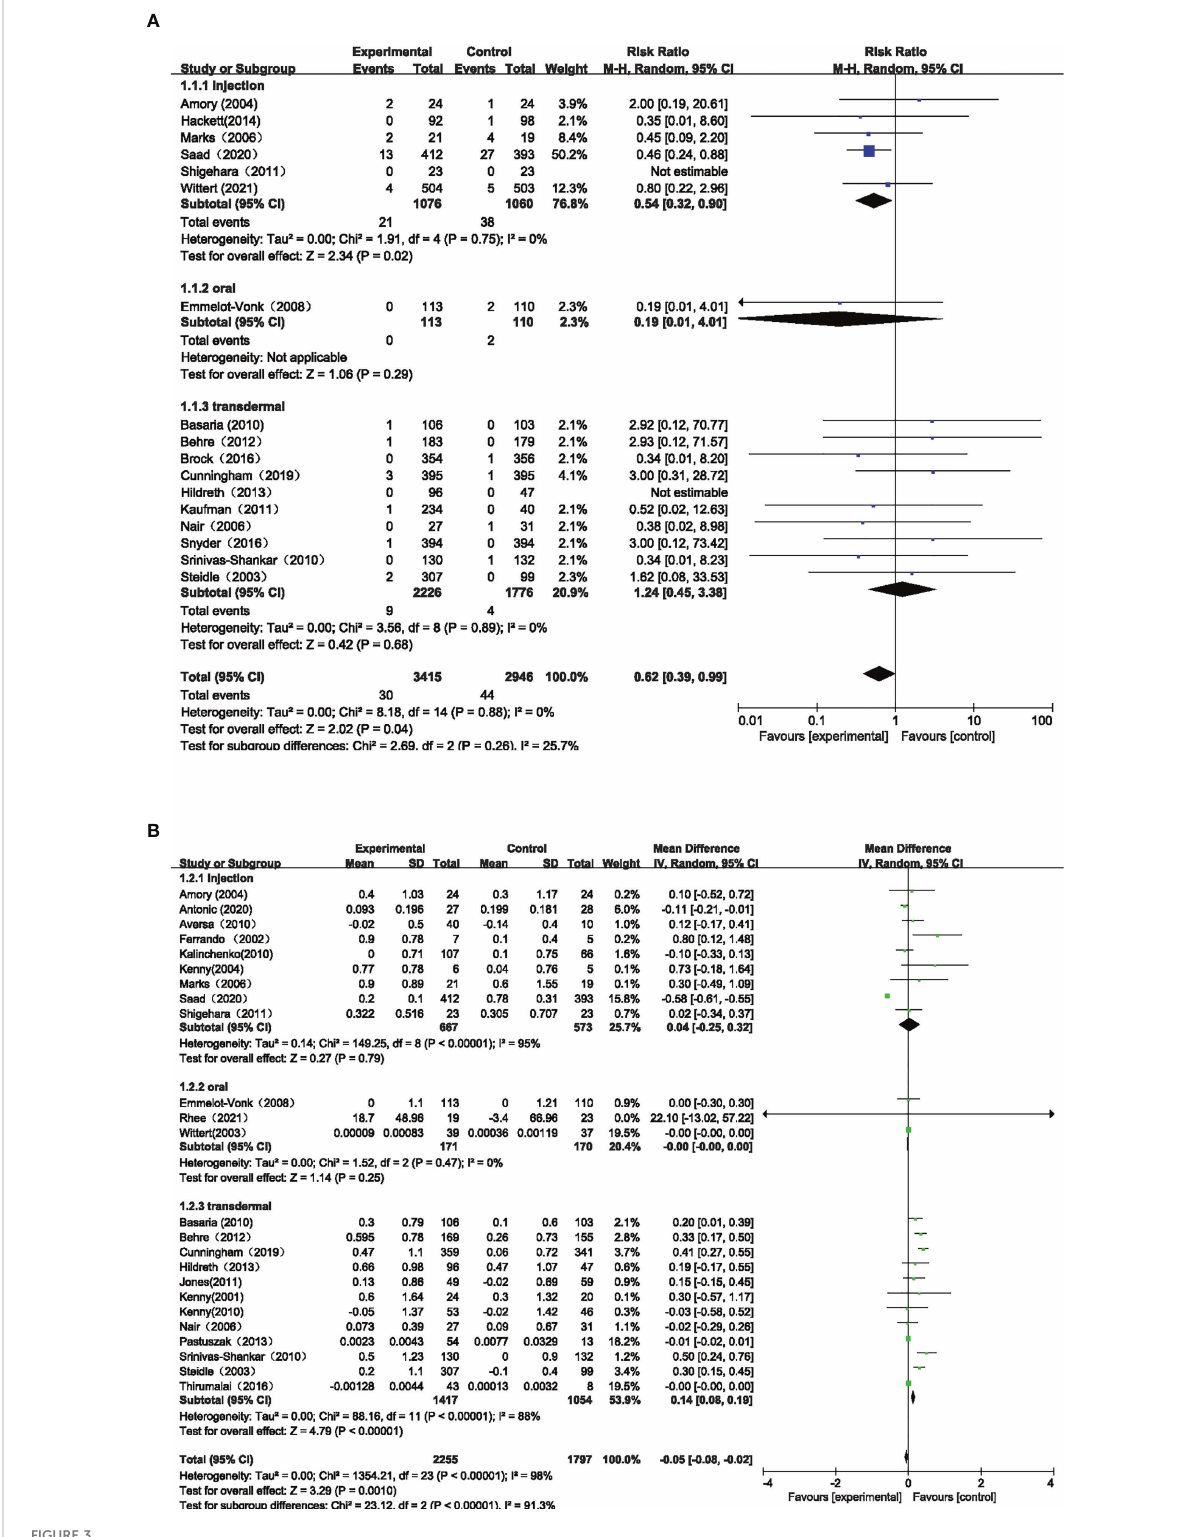
FIGURE 3 Pairwise Meta-analysis for primary outcomes. (A) Pca Cases; (B) PSA Level